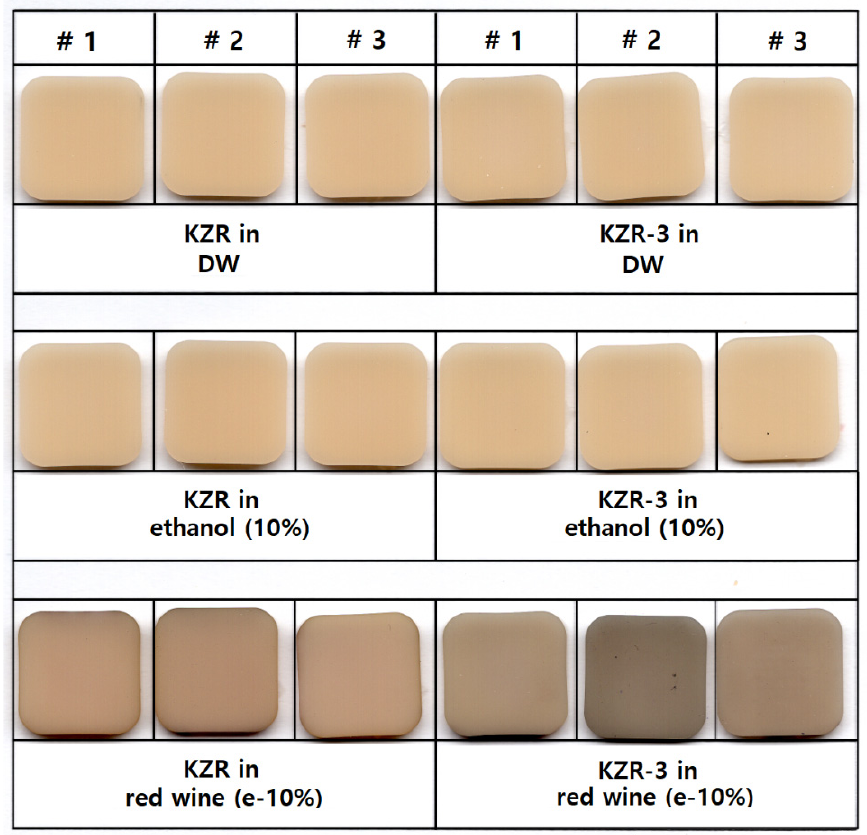
Figure 1. KZR and KZR-3 block specimens after color stability test (12-week immersion in staining solutions).